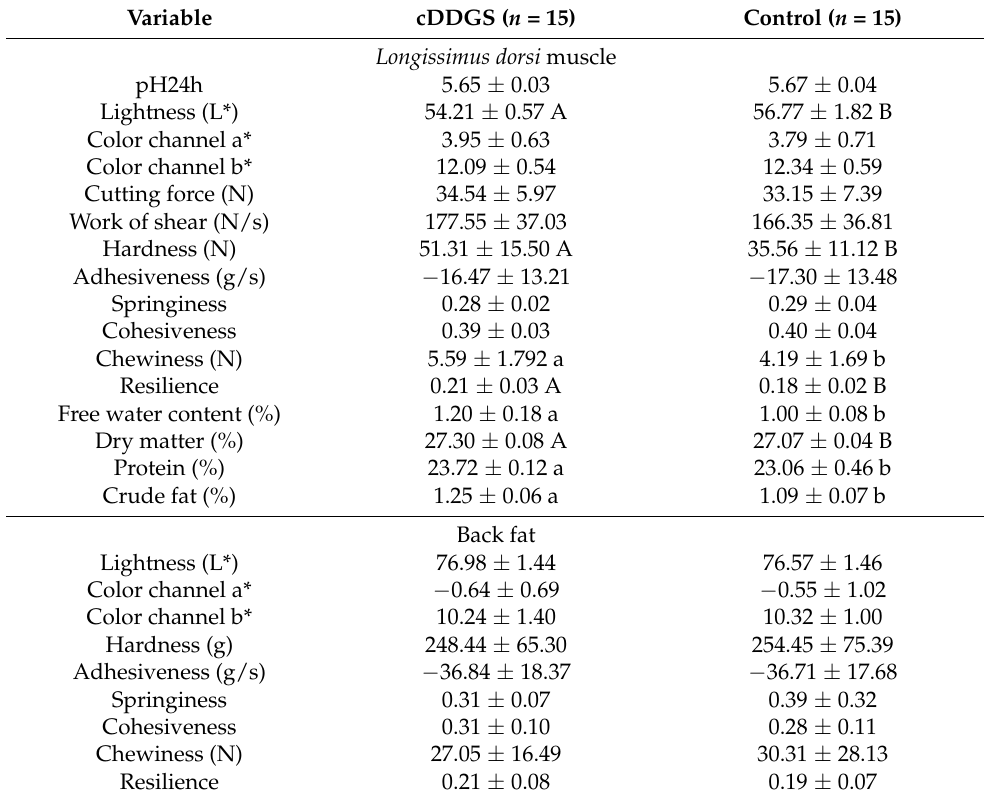
Table 7. Main physicochemical parameters (means ± SDs) of raw longissimus dorsi muscle and back fat